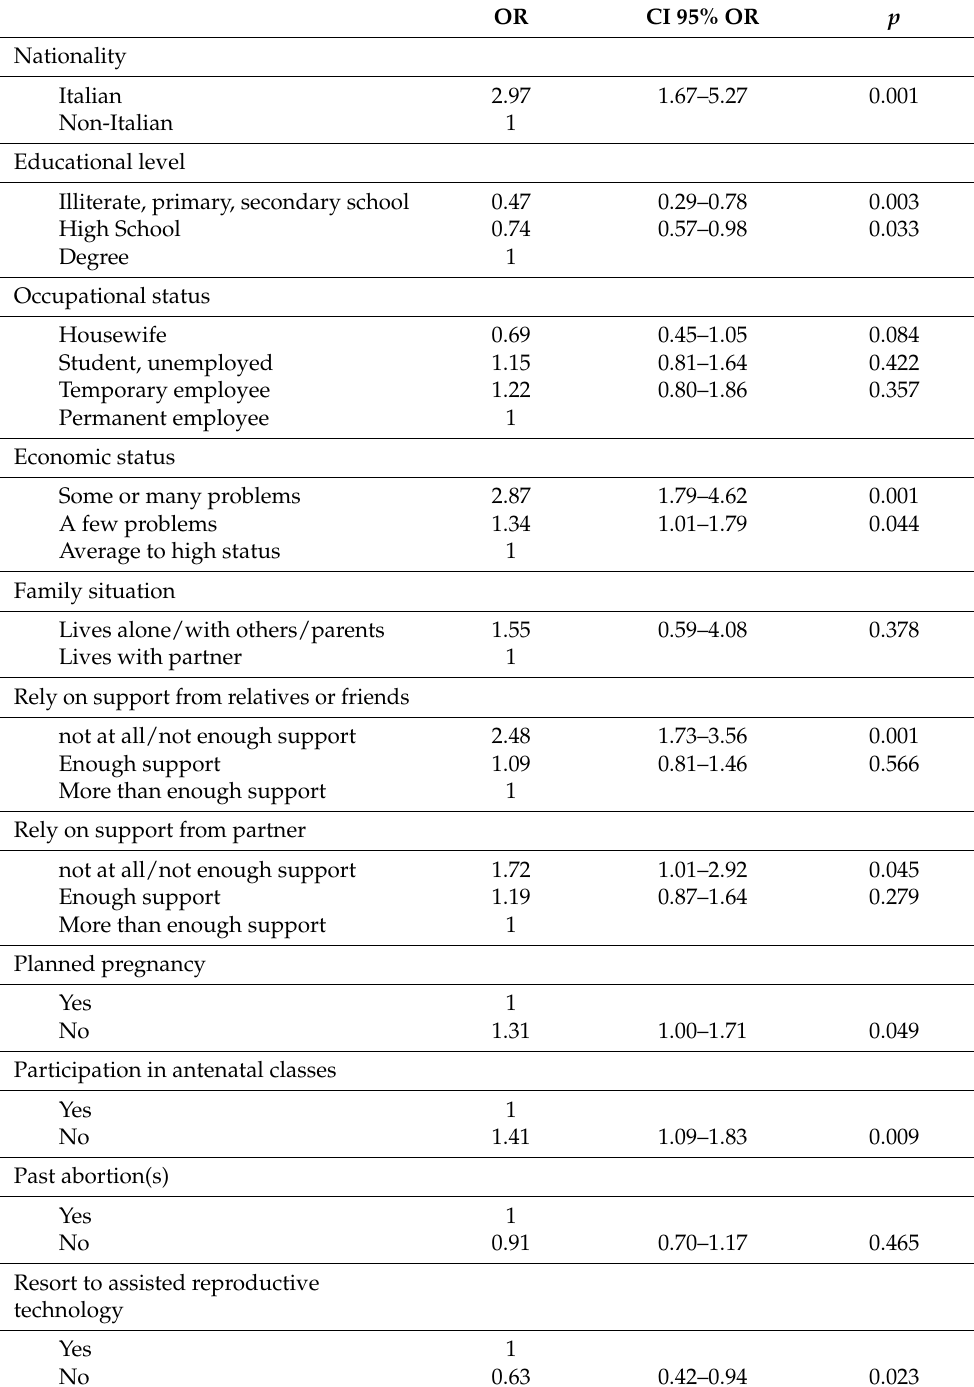
Table 5. Association of sociodemographic and socioeconomic characteristics and risk of anxiety (GAD-7 score ≥ 8): results of multiple logistic regression